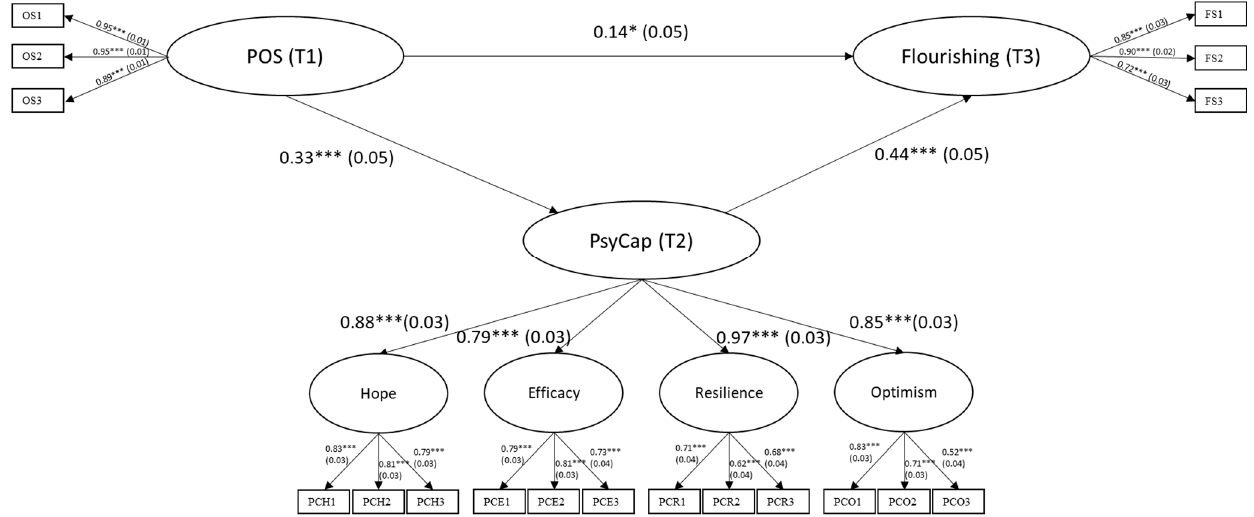
Figure 1. Structural Equation Model from Perceived Organizational Support to Psychological Capital to Flourishing. (Note. Standardized factor loadings and standardized path coefficients are